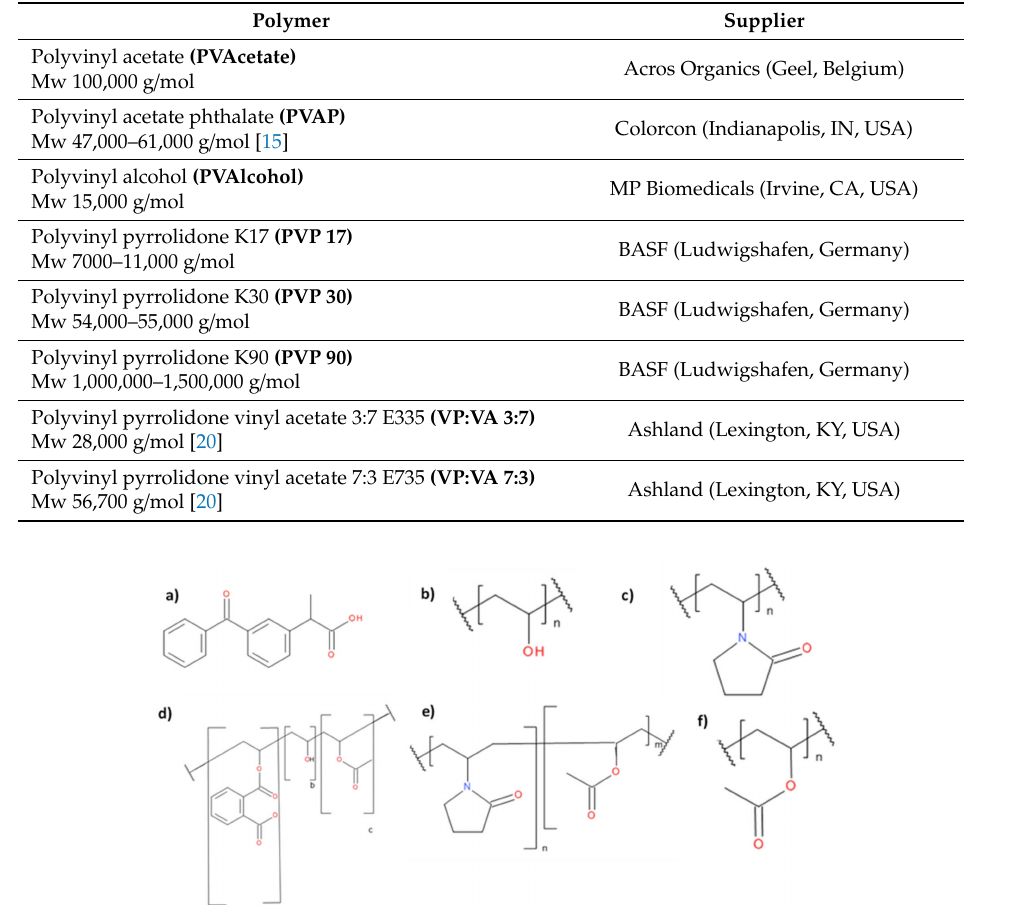
Figure 1. Molecular structures of ( a ) ketoprofen, ( b ) polyvinyl alcohol (PVAlcohol), ( c ) polyvinyl pyrrolidone (PVP), ( d ) polyvinyl acetate phthalate (PVAP), ( e ) polyvinyl pyrrolidone vinyl acetate (VP:VA), ( f ) polyvinyl acetate